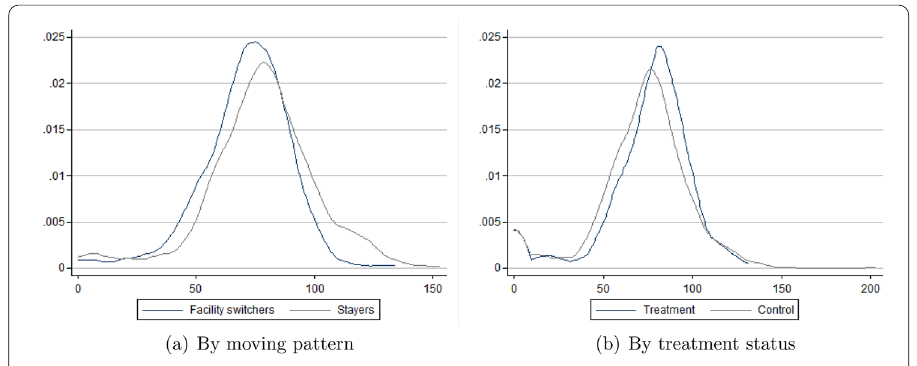
Fig. 2 The wage distribution by moving pattern and treatment status. a Displays the wage distribution (kernel density) of graduates that leave the training facility after their graduation within the first 100 days after graduation and of graduates that do not leave their training facility within the first 100 days after graduation. In b , the wage distribution is compared between graduates who started their apprenticeship training under the regime of the levy scheme (treatment group) and graduates who started their apprenticeship training when the levy scheme has not been introduced (yet). Source: Sample of Integrated Labour Market Biographies 1975 -2017 (SIAB 7517v1); Regional Database of the Federal Statistical Office and the Federal Employment Agency, own